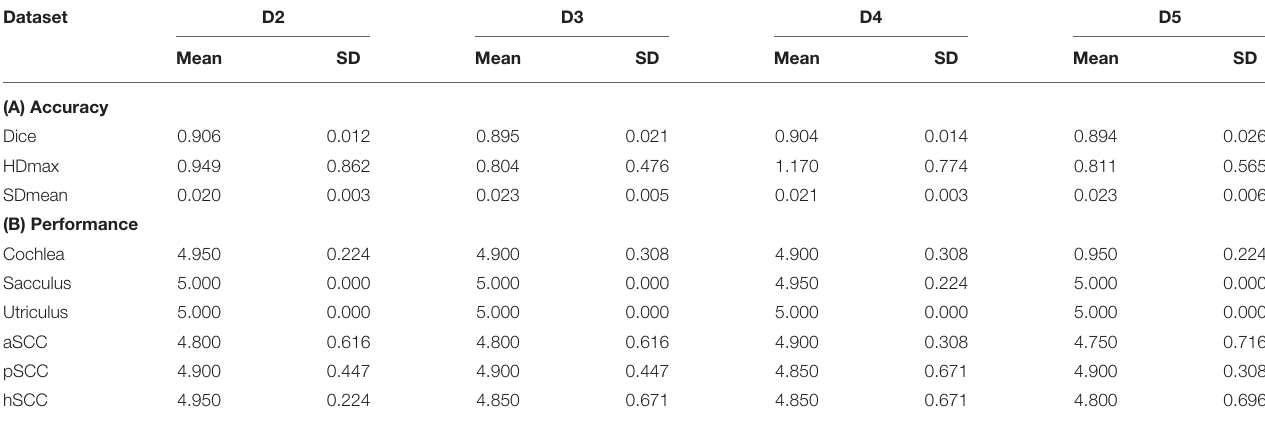
TABLE 2 | IE-Vnet segmentation results on four test datasets D2-D5 (20 inner ears each) compared to manual ground-truth.